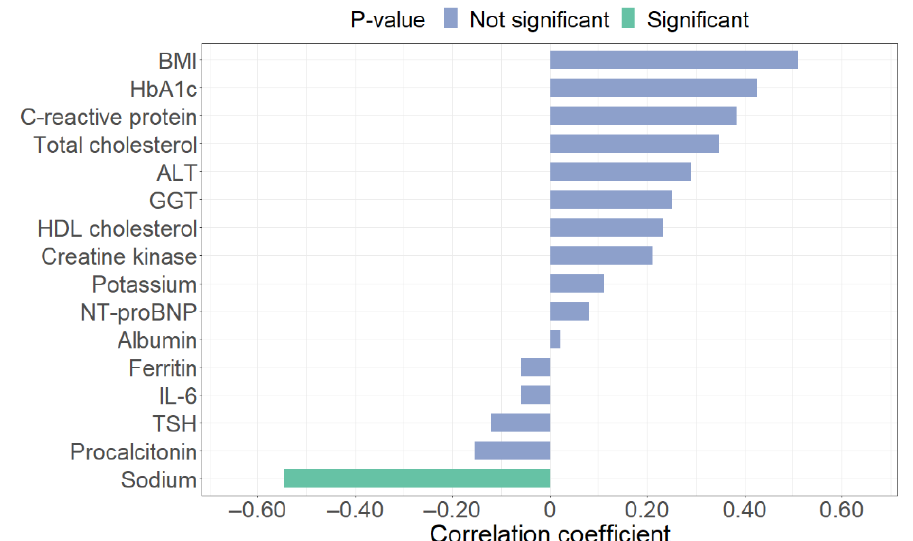
Figure 1. Spearman correlation coefficients between clinical and biochemical parameters and ho-